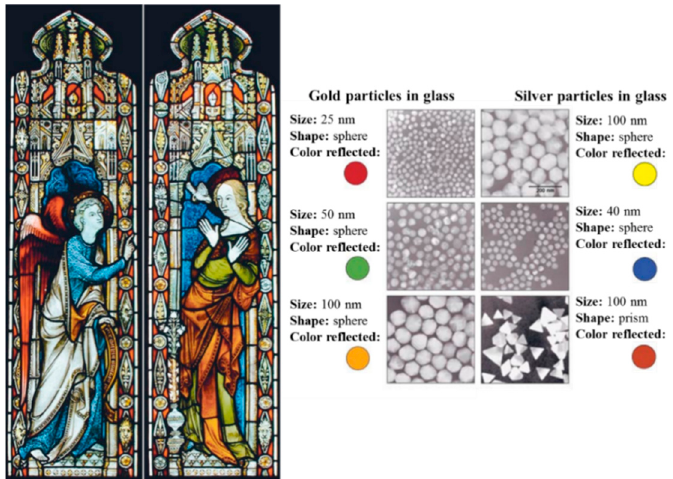
Figure 4 . Effect of nanoparticles on the colors of the stained glass windows. Reproduced with permission from reference [14].